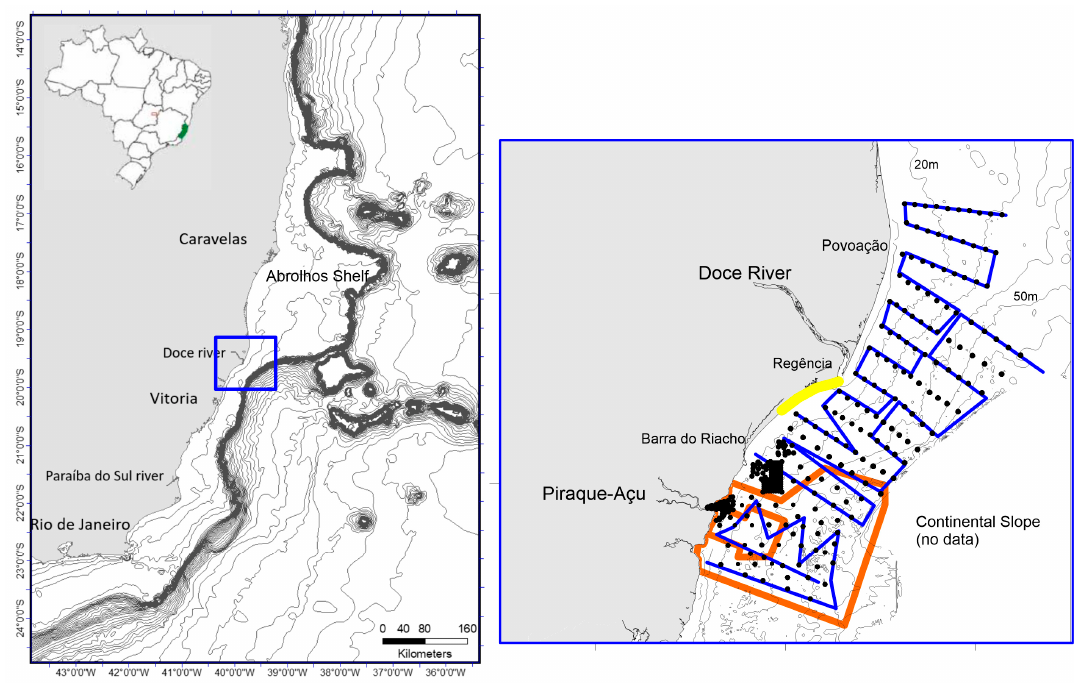
Figure 1. Study area location along the Southeast Brazilian Shelf. Black dots are sampling sites and blue lines are side scan sonar and sub-bottom profiler transects. Orange polygons are the Marine Protected Area—Costas das Algas MPA and the Wildlife Refuge Santa Cruz (inner polygon). Yellow line represents the Comboios Biological Reserve.